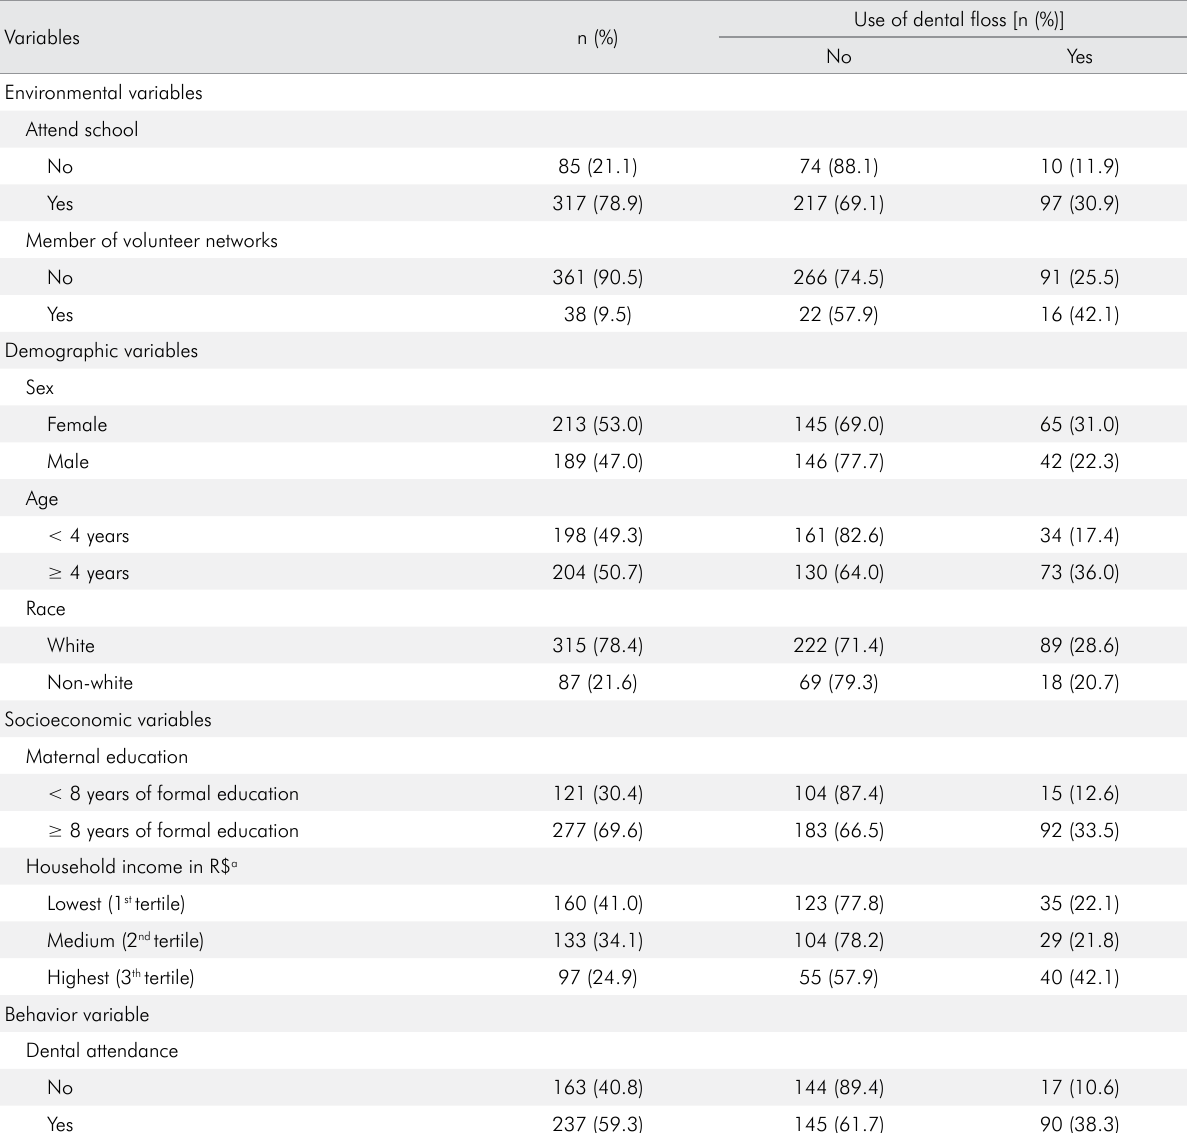
Use of dental floss [n